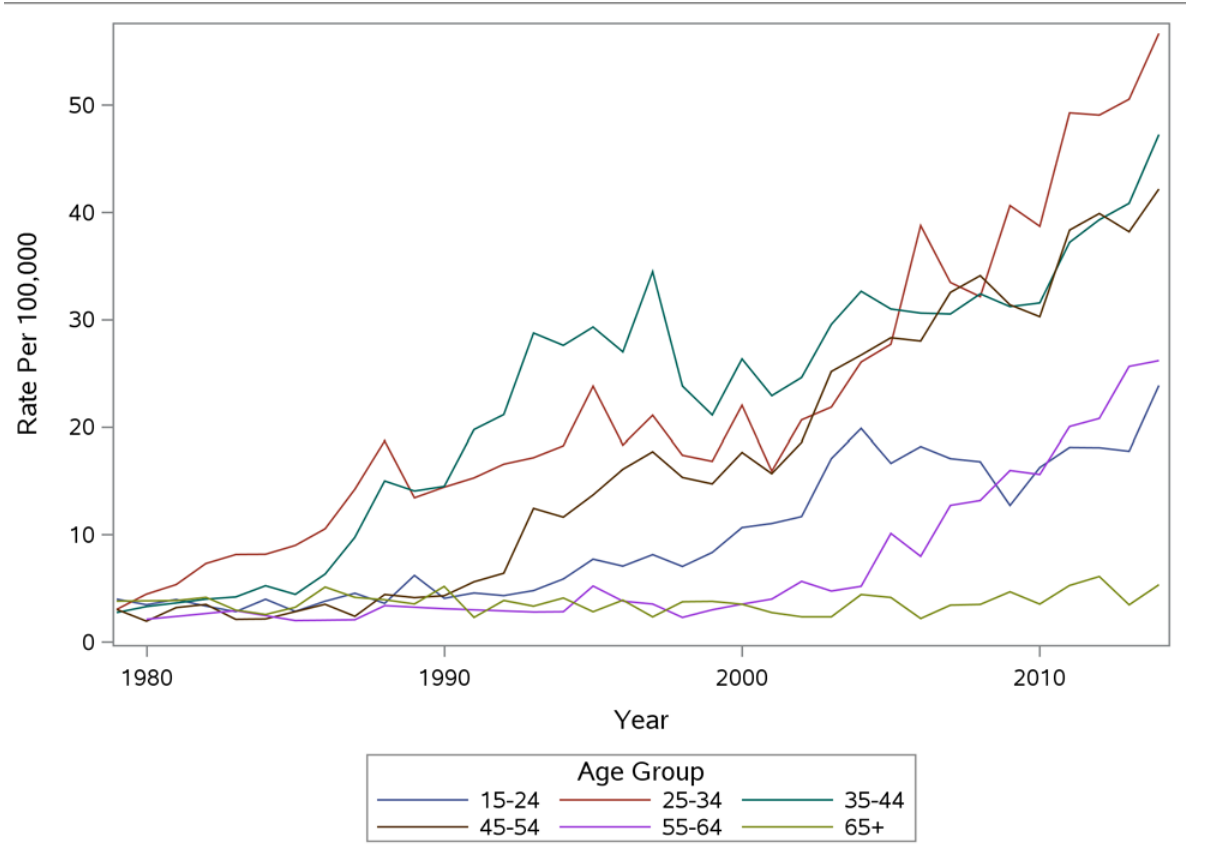
Fig 2. PA Accidental Poisoning Mortality Rate Per 100,000 Females by Age